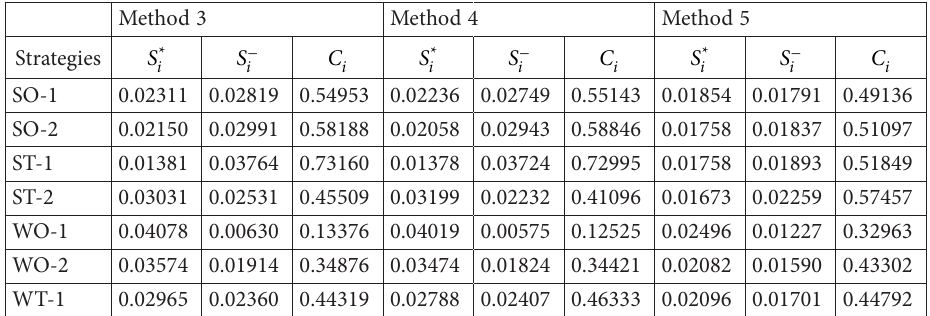
Table 12. Ranking obtained by TOPSIS